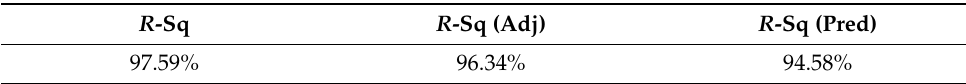
Table 10. R value for density by RSM.